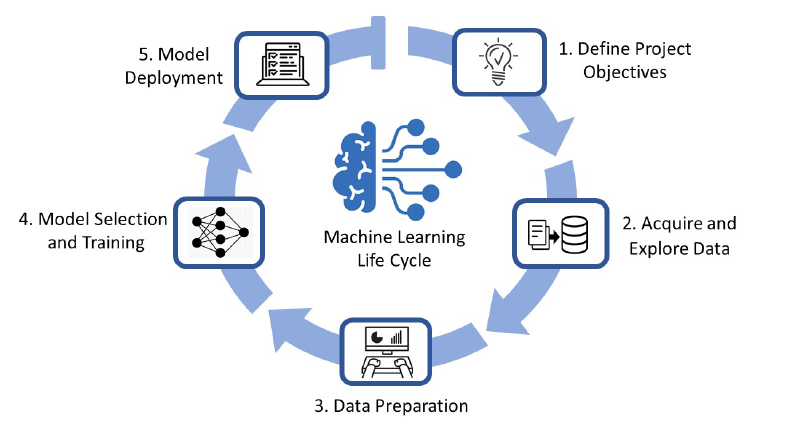
Figure 3. Machine Learning Life cycle Schematic